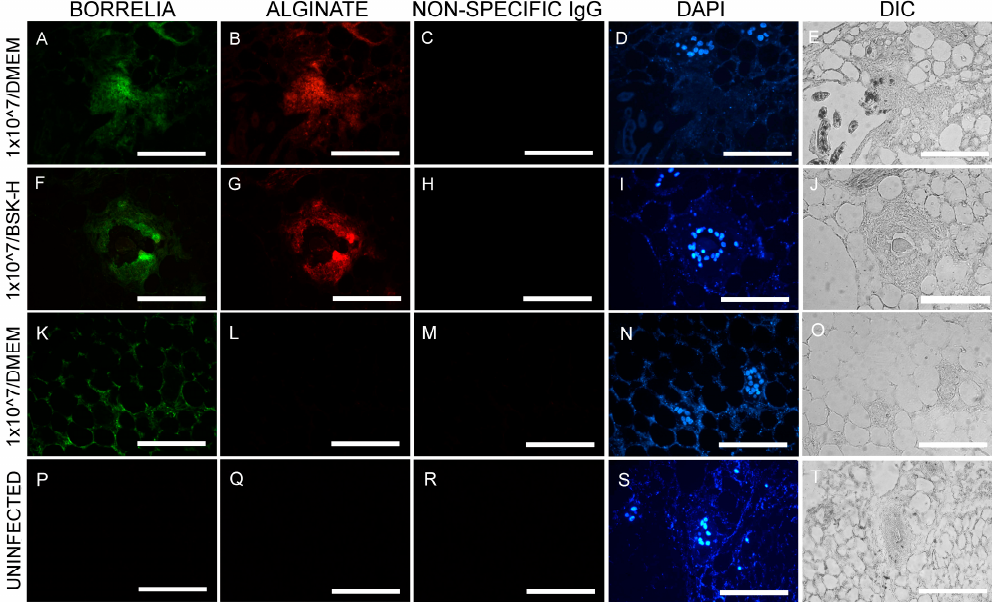
Figure 2. Representative images of IHC experiments for B. burgdorferi in murine skin biopsies inoculated at 1 × 10 7 cells. Panels ( A , F , K , P ) show the results for anti- B. burgdorferi and panels ( B , G , L , Q ) for anti-alginate antibodies. DAPI nuclear stains (blue staining: panels D , I , N , S )) and differential interference contrast microscopy (panels ( E , J , O , T )) were used to visualize the tissues. Negative controls include staining of uninfected skin ( P , Q , R , T ) and the use of a non-specific IgG ( C , H , M , R ). 400 × magnification, scale bars show 100 μ m.